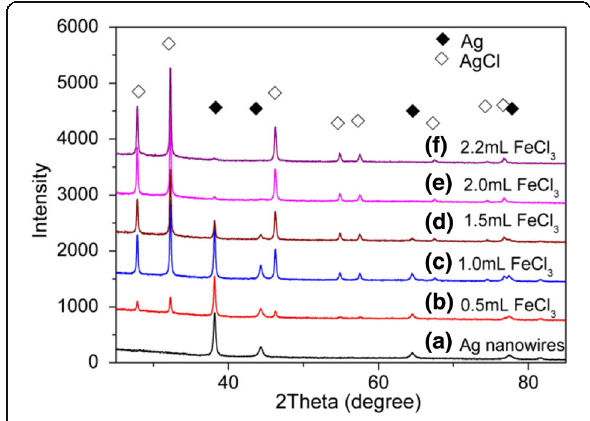
Fig. 3 The XRD patterns of ( a ) Ag nanowires and Ag@AgCl core – shell nanowires with different mole ratio of Ag:AgCl. Ag@AgCl core – shell nanowires were synthesized through the reaction between 250 μ L Ag nanowire dispersion and ( b ) 0.5, ( c ) 1.0, ( d ) 1.5, ( e ) 2.0, and ( f ) 2.2 mL of 20 mM FeCl 3